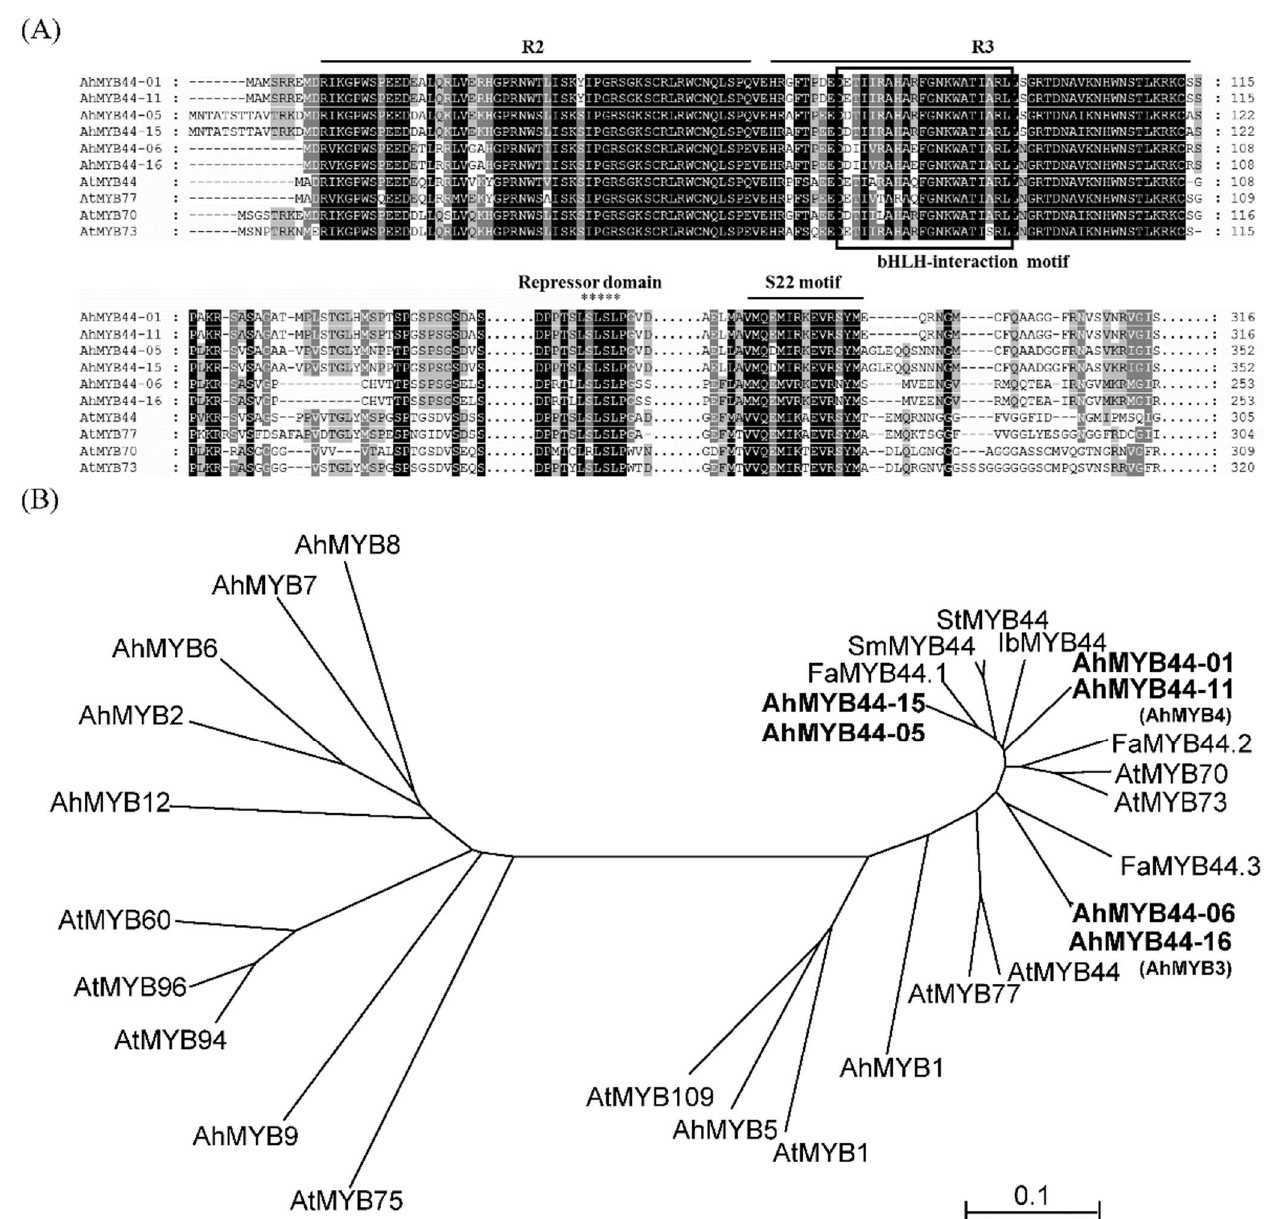
Figure 1. Phylogenetic analysis and multiple sequence alignment of MYB44. ( A ). Multiple sequence alignment was performed using the protein sequences of AhMYB44s and Arabidopsis MYB S22 (AtMYB44, AtMYB70, AtMYB73, AtMYB77). The R2 and R3 domains are labeled, and bHLH-interaction motifs were included in the R3 domain; the negative repressor motif LxLxL and the conserved domain of Arabidopsis MYB S22 are all labeled. ( B ). Phylogenetic analysis of MYB44s from diverse plant species and some R2R3-MYBs from Arabidopsis and peanut. The amino acid sequences are indicated as follows: Ah, Arachis hypogaea ; At, Arabidopsis thaliana ; Fa, Fragaria × ananassa ; Sm, Solanum melongena ; St, Solanum tuberosum ; Ib, Ipomoea batatas . The scale bars indicate that 10 of every 100 amino acids showed differences.